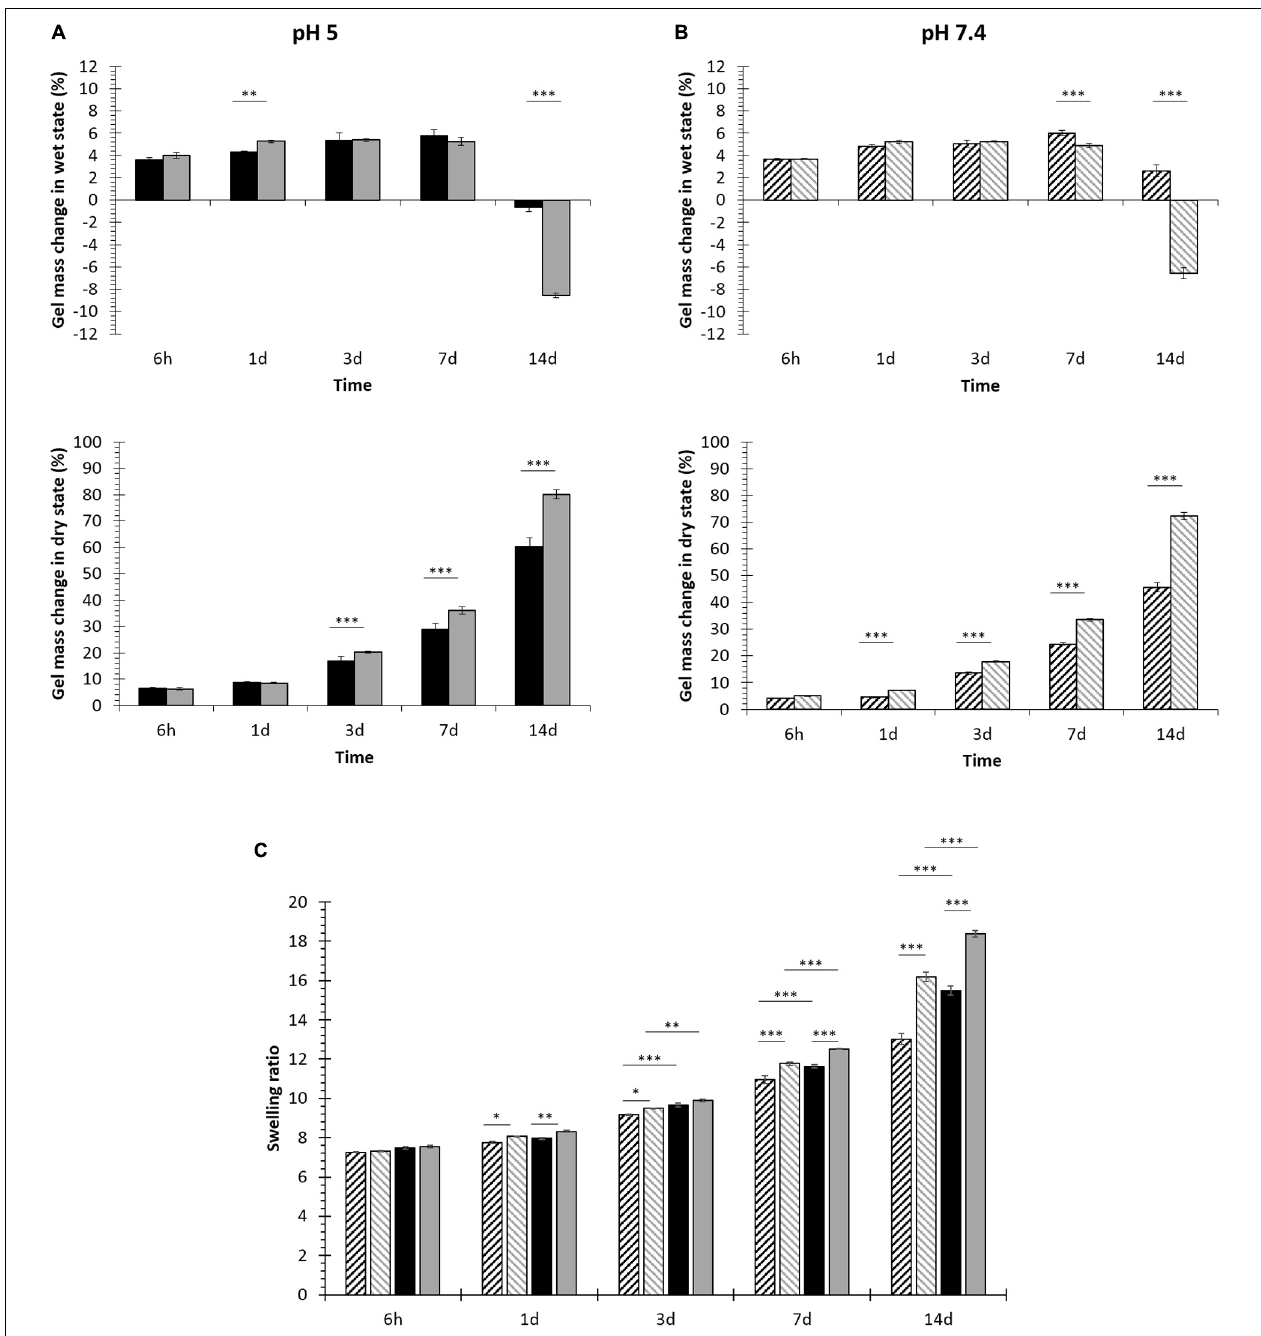
FIGURE 3 | NHP407 (black) and SHP407 (gray) gel behavior in aqueous environments at different pH values. (A) Percentage of swelling and dissolution over time for NHP407 and SHP407 gels incubated in an aqueous medium at pH 5. (B) Percentage of swelling and dissolution over time for NHP407 and SHP407 gels incubated in PBS (pH 7.4). (C) Swelling ratio evaluated for NHP407 (black) and SHP407 (gray) gels incubated in acetate buffer at pH 5 (plain) or PBS (patterned) for different time intervals (6 h, 1, 3, 7, and 14